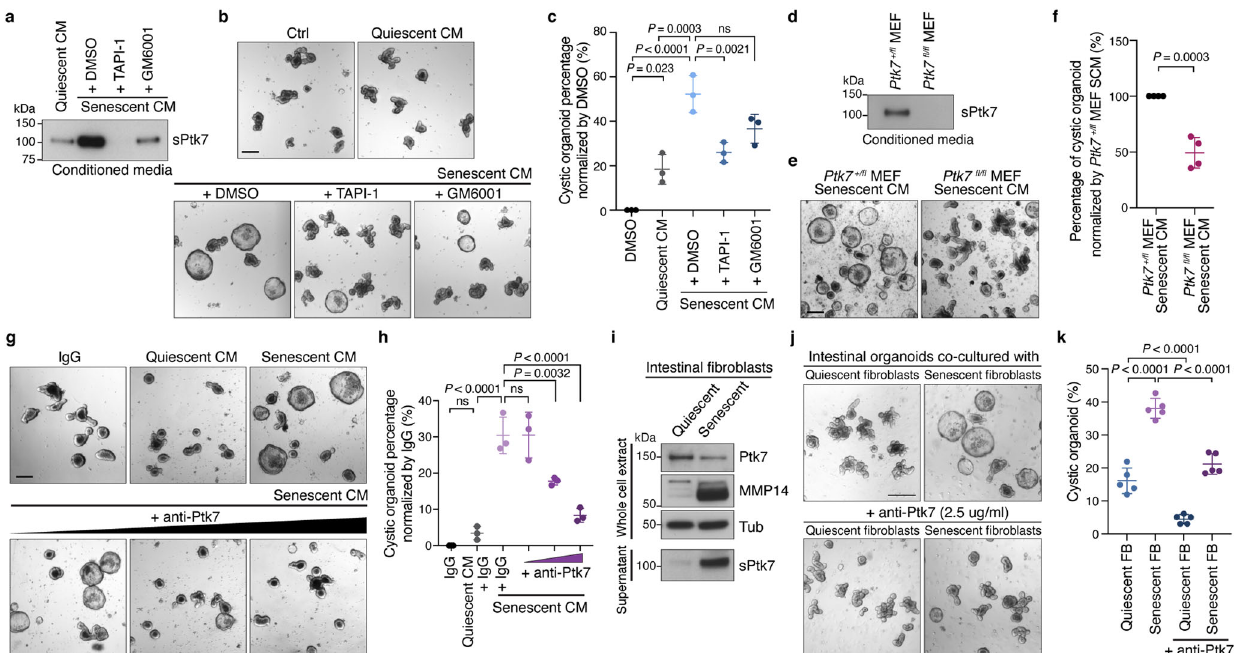
Fig. 3 | SCM-induced cystic organoid phenotype is dependent on Ptk7. a Western blot for sPtk7 in conditioned media collected from quiescent and senescent MEFs treated with vehicle or inhibitors for 24 h. Conditioned media correspondingtothesamenumberofcellswasloaded. b Representativeimagesof organoids cultured in corresponding conditioned media. Scale bar, 200 μ m. c Quanti fi cation of data from ( b ). The percentage of cystic organoids is shown. d WesternblotforsPtk7inconditionedmediacollectedfromsenescentPtk7 +/ fl and Ptk7 fl / fl fi broblasts. Conditioned media corresponding to the same number of cells was loaded. e Representative images of organoids cultured in corresponding conditioned media. Scale bar, 200 μ m. f Quanti fi cation of data from ( e ). g